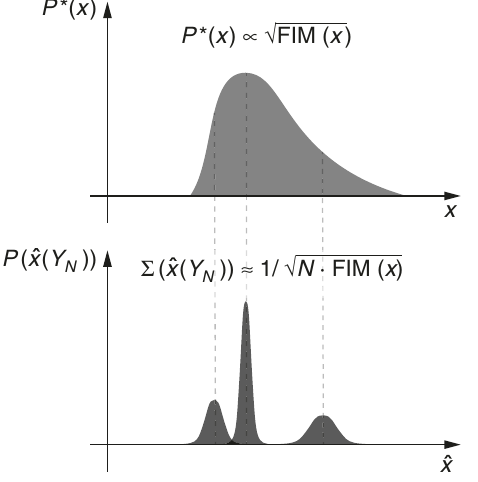
Fig. 2 Information transmission is maximized when frequent signals are SN recognized with high precision. Given the asymptotic interpretation (10), for a system with one-dimensional input, the standard deviation of the ffiffiffiffiffiffiffiffiffiffiffiffiffiffiffiffiffiffiffiffiffi p . C (cid:1) was 1 N (cid:4) FIM ð x Þ signal estimate is given as Σ ð ^ x Þ (cid:6) 1 = . Then, the asymptotically F ð x Þ , is de fi ned in terms of uncertainty optimal input distribution, P (cid:1) JP